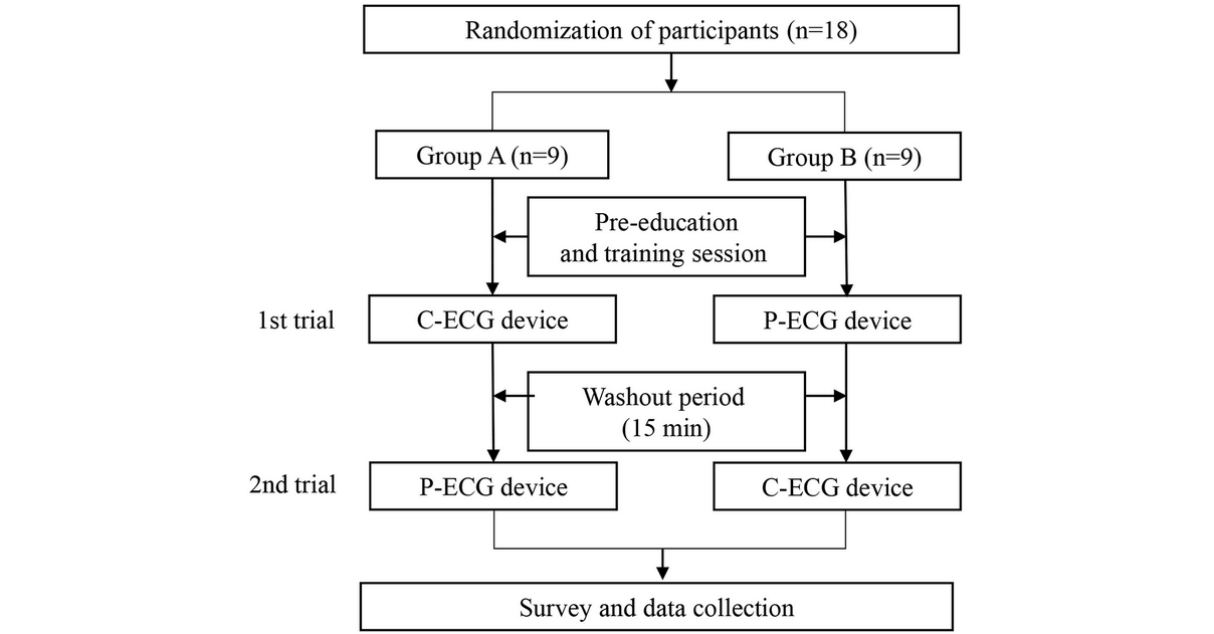
Figure 4. Case-crossover design study process. There was a washout period before two trials. C-ECG: conventional 12-lead electrocardiogram; P-ECG: patchy-type wireless 12-lead